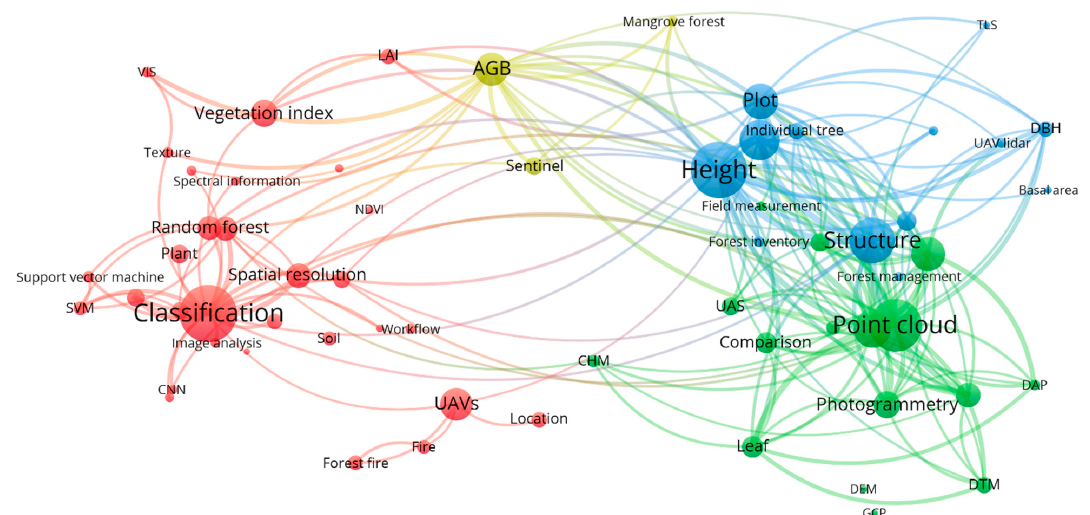
Figure 5. Scientific mapping of keyword networks for UAV in forestry applications based on the cluster method (2018–mid-2020). Abbreviations: GCP = Ground Control Point; NDVI = Normalized Difference Vegetation Index, OBIA = Object-Based Image Analysis, TLS = Terrestrial Laser Scanning, VIS = Visible Spectrum; other abbreviations are reported in the text.